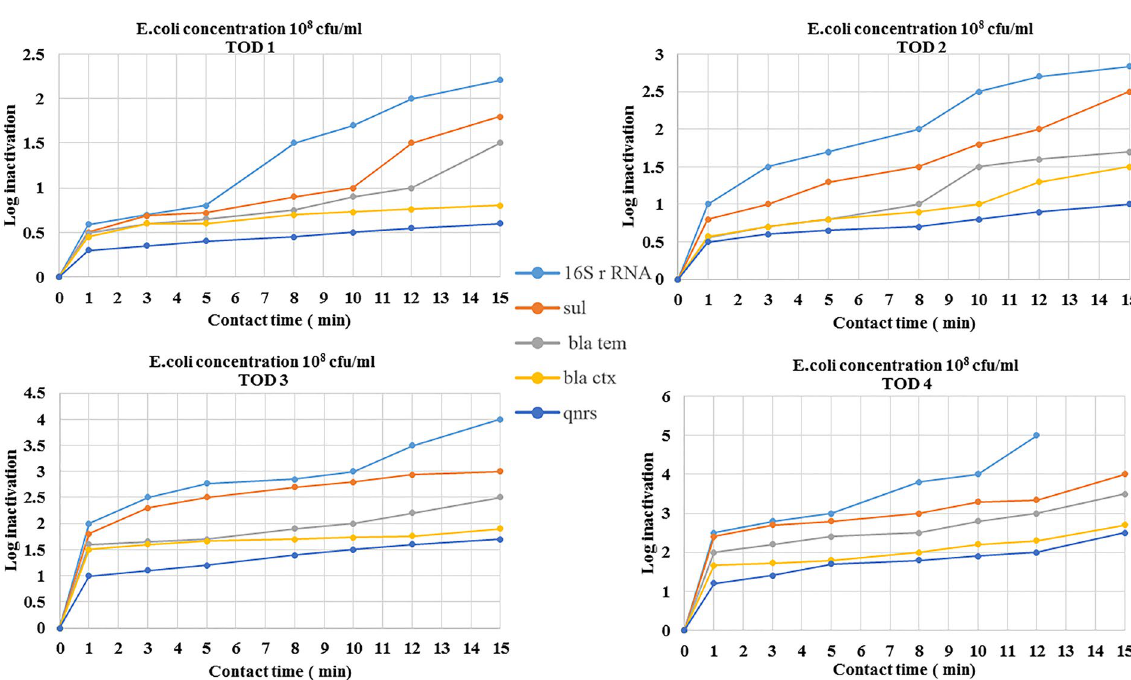
Figure 4. Removal efficiencies of antibiotic resistance genes in Escherichia coli by ozonation at ozone doses of 11–45 mg/l (TOD1 = 11 mg/l, TOD2 = 25 mg/l, TOD3 = 37 mg/l, TOD4 = 45